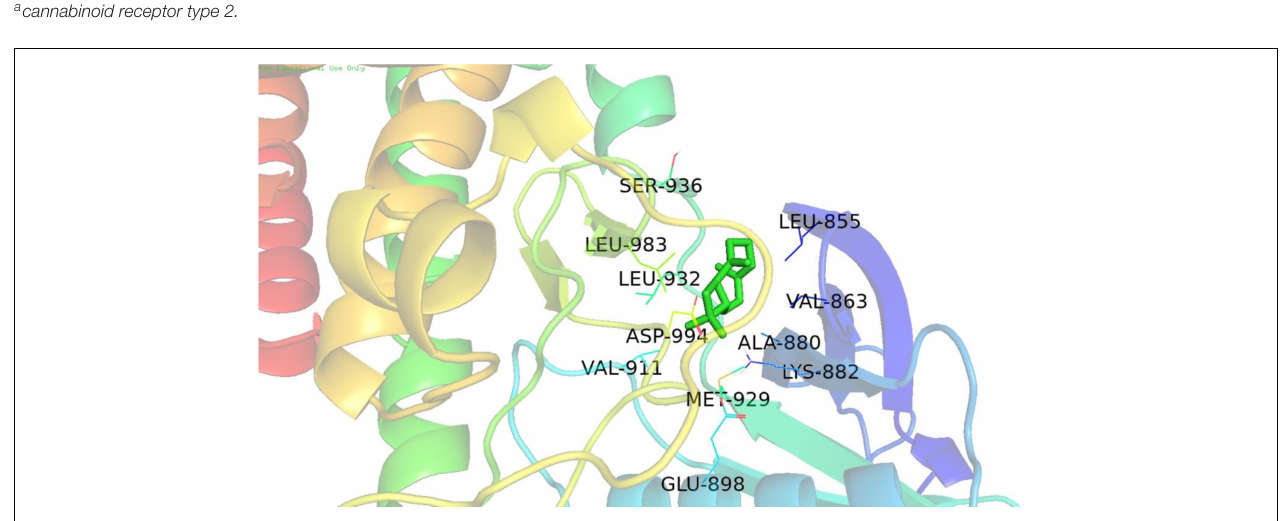
FIGURE 6 | The best docking stability model. Model of the putative interaction of (+)- β -caryophyllene with the JAK2 receptor